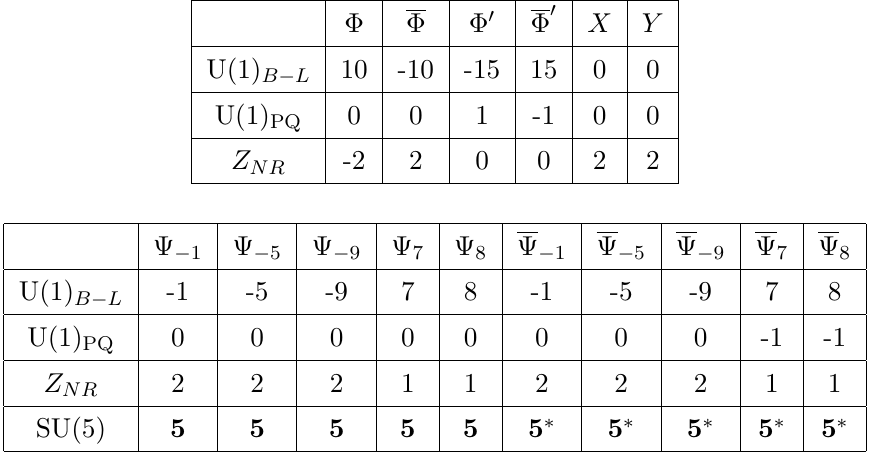
Table 2 . Charge assignment of the newly introduced hidden